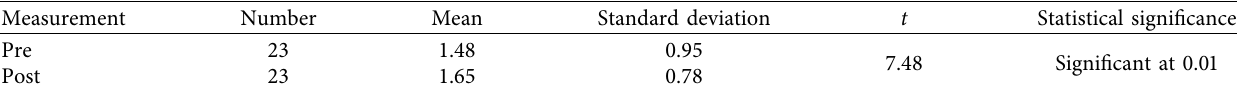
Table 7: The results of the t -test and the significance of the differences for the two measurements, pre and post, for the experimental group in the reading comprehension skills test at the deductive comprehension level.